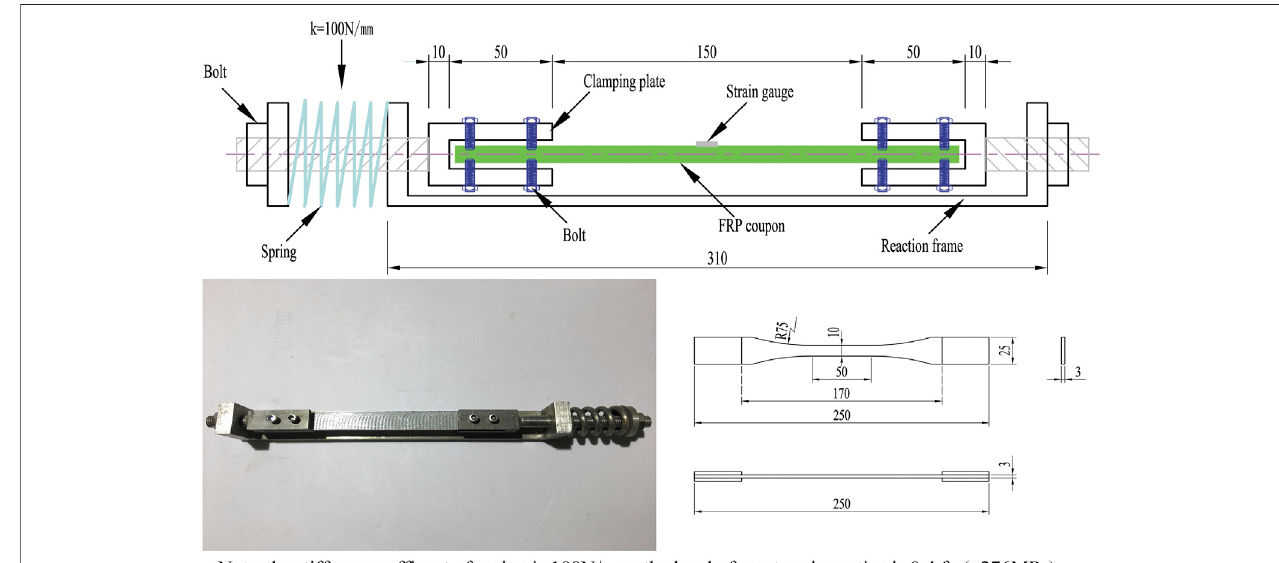
FIGURE 2 | Prestressing equipment and GFRP tensile test coupons